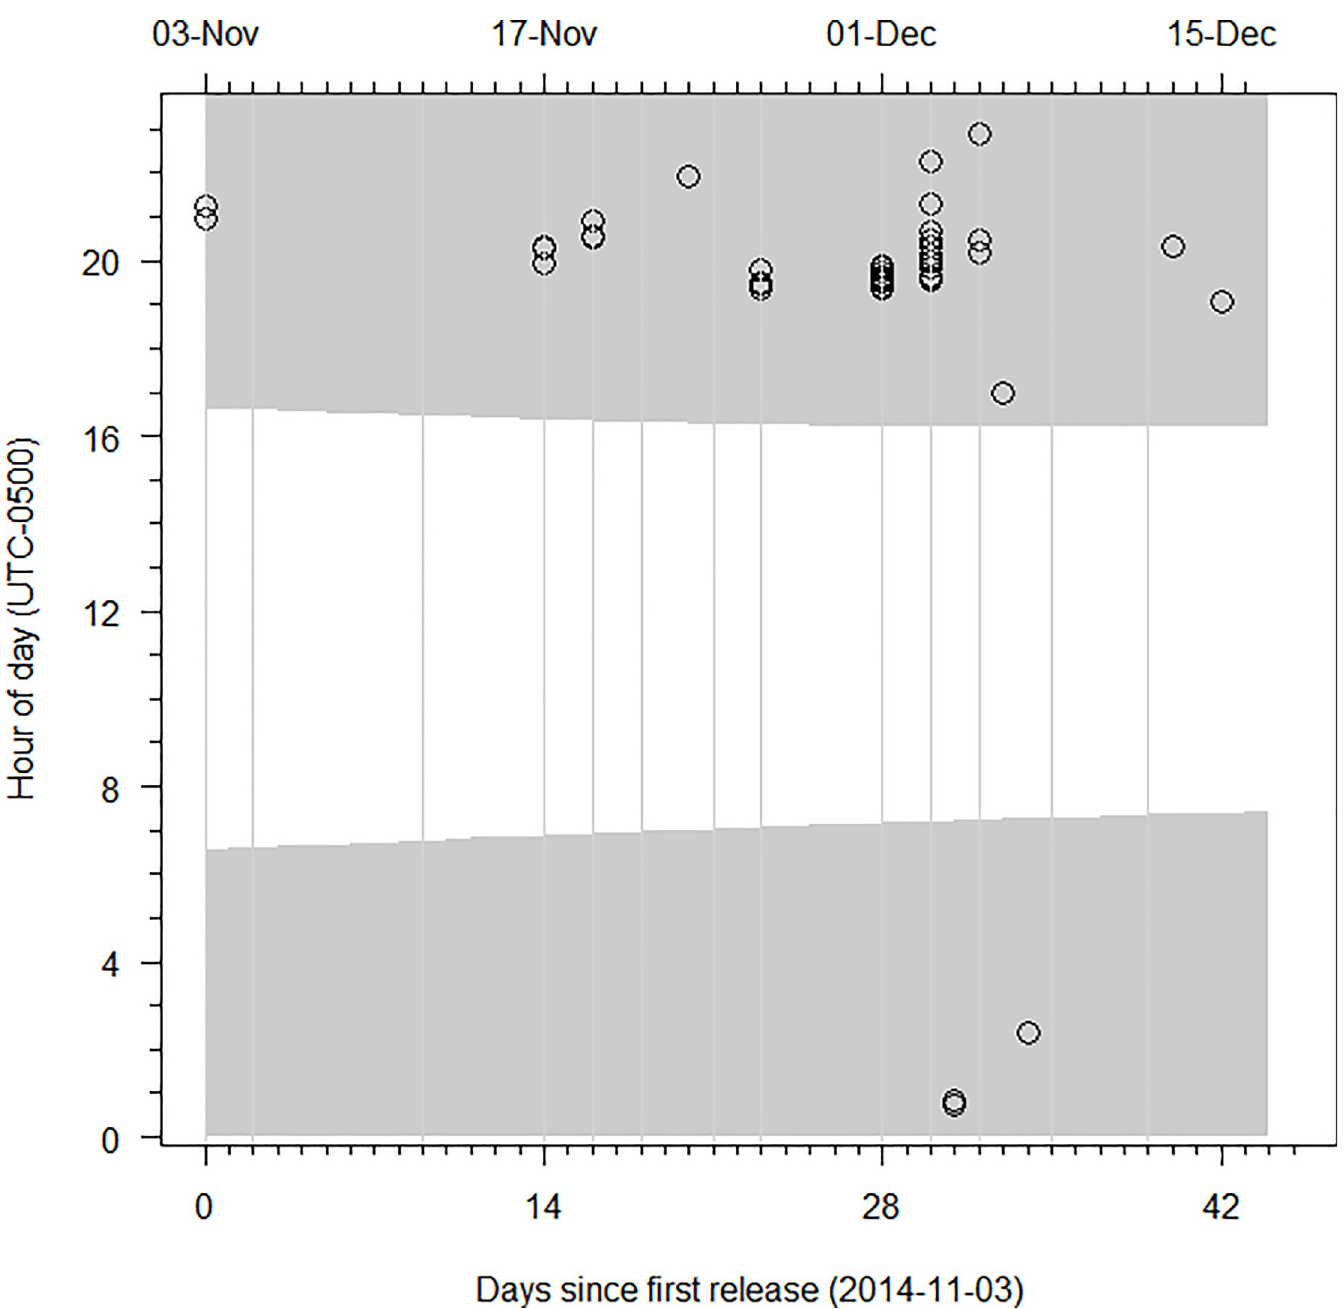
Fig 3. Study II: Timing of downstream movement by juvenile sea lamprey. Detections of PIT implanted juvenile sea lamprey (circles) are shown by time of day (y- axis) for individuals that moved downstream past PIT antenna arrays installed in Morpion Stream, Quebec. Groups of lamprey were tagged and released approximately 5 km upstream of antenna arrays throughout the observation period November 3, 2014 –December 17, 2014. Shading indicates period between sunset and sunrise. Vertical grey lines indicate release